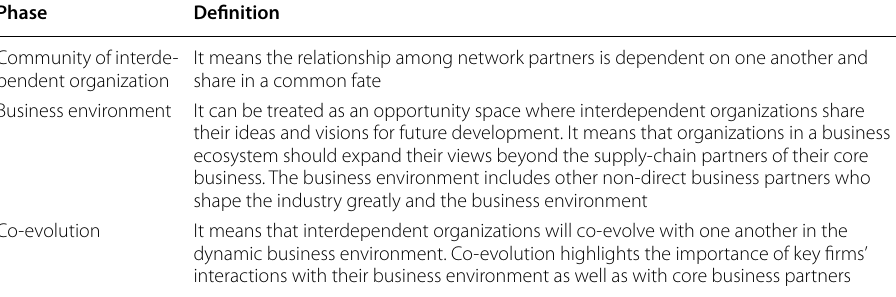
Table 3 Three key phases in the business ecosystem (Rong and Shi 2015)